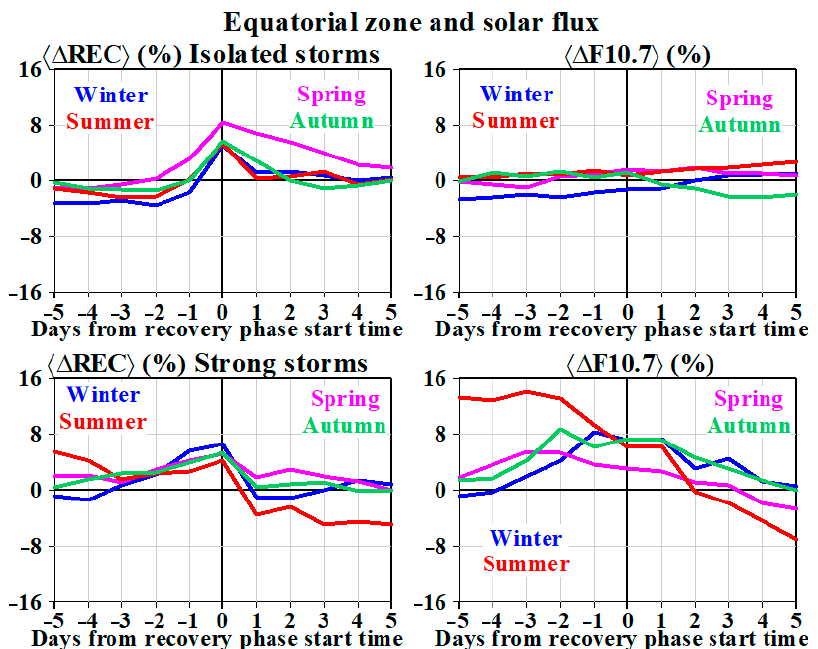
Figure 4. Average response in ∆ REC (‹ ∆ REC ›) for equatorial zone ( left panel ) and average value 4444 of ∆ F10.7 (‹ ∆ F10.7 ›, right panel ) as functions of day from beginning of geomagnetic storm recovery. Upper and lower panels show ‹ ∆ REC › and (‹ ∆ F10.7 › for isolated and strong storms, respectively. Blue, magenta, red, and green curves correspond to winter, spring, summer, and autumn,